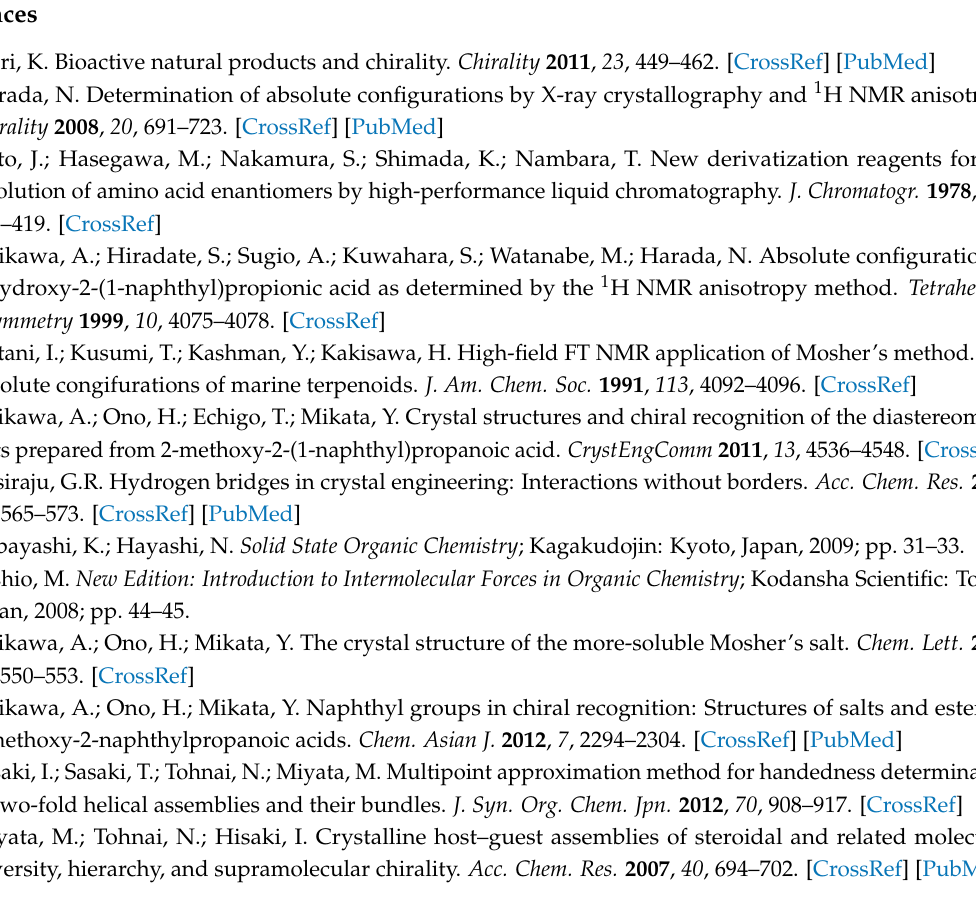
Supplementary Materials: The following is available online at www.mdpi.com/2073-4352/7/9/263/s1, Figure S1: Top and side views of sheet structures in salts 6 – 9 shown in space-filling models. Author Contributions: Akio Ichikawa designed and performed the experiments; Yuji Mikata obtained and analyzed the data of X-ray crystallography; Akio Ichikawa, Hiroshi Ono, and Yuji Mikata discussed the results. Conflicts of Interest: The authors declare no conflict of